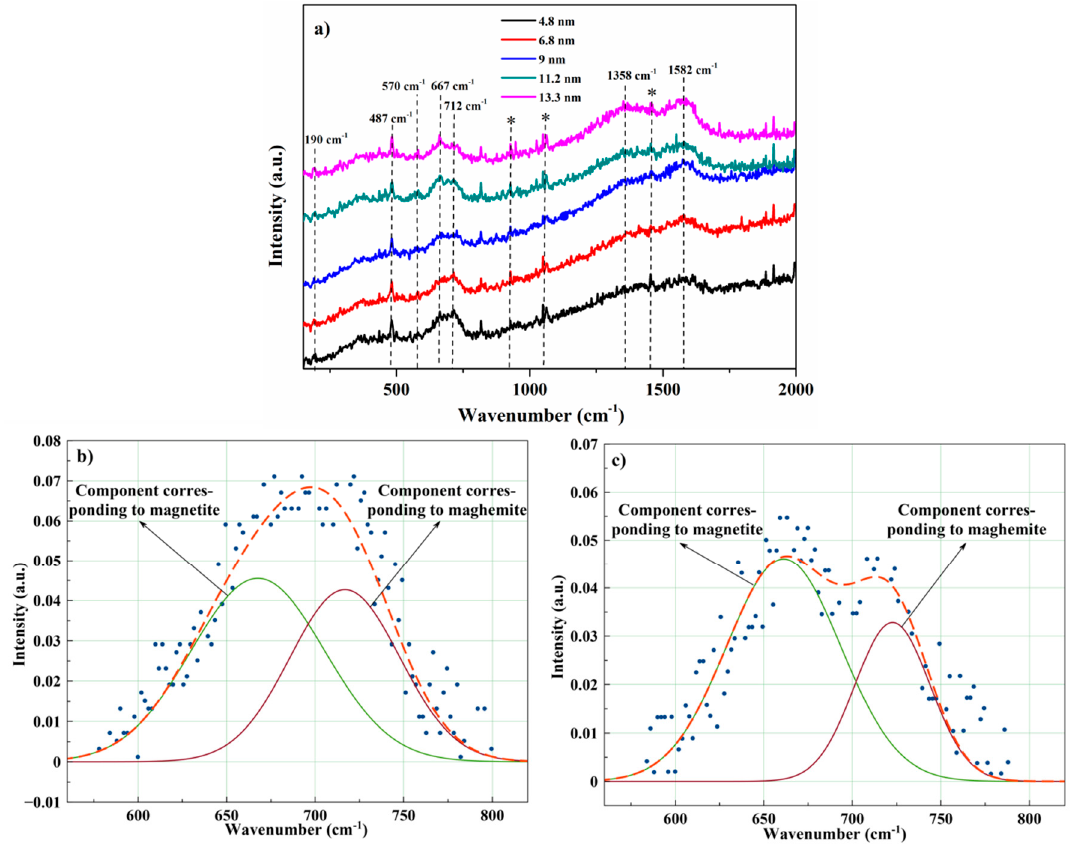
Figure 2. Raman spectra of magnetite nanoparticles synthesized at different reaction temperatures ( a ) and the best Gaussian fitting for the A 1g peaks of the samples with d = 4.8 nm ( b ) and 13.3 nm ( c ); *— artifacts.